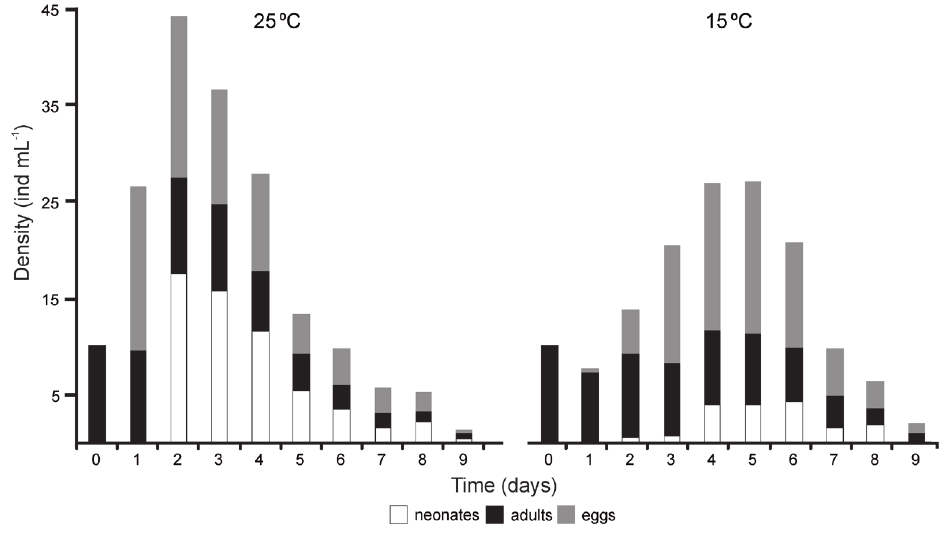
Figure 3 - Population structure of Brachionus plicatilis with respect to the density of eggs, adults, and neonates at temperatures of 25 and 15